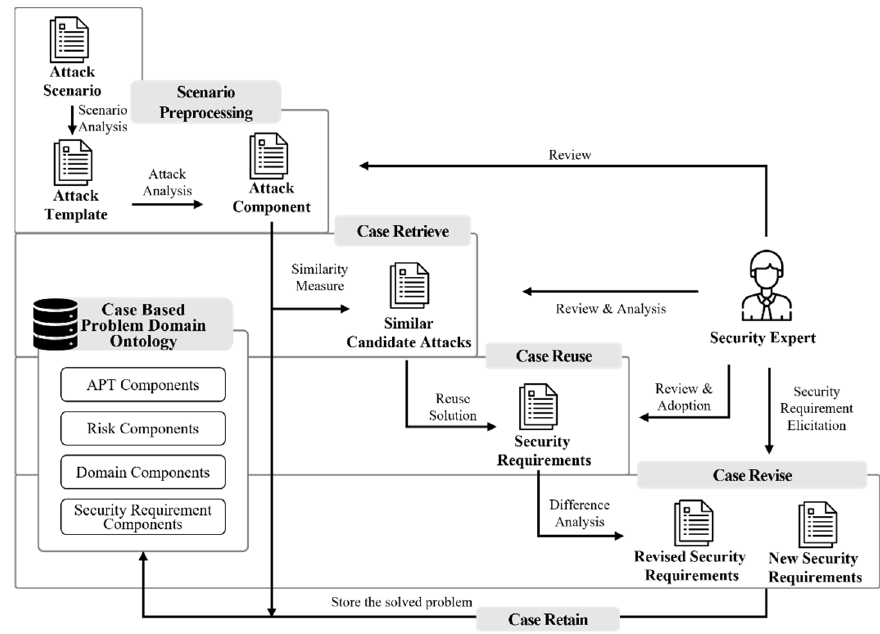
Figure 2. Overview of our proposed